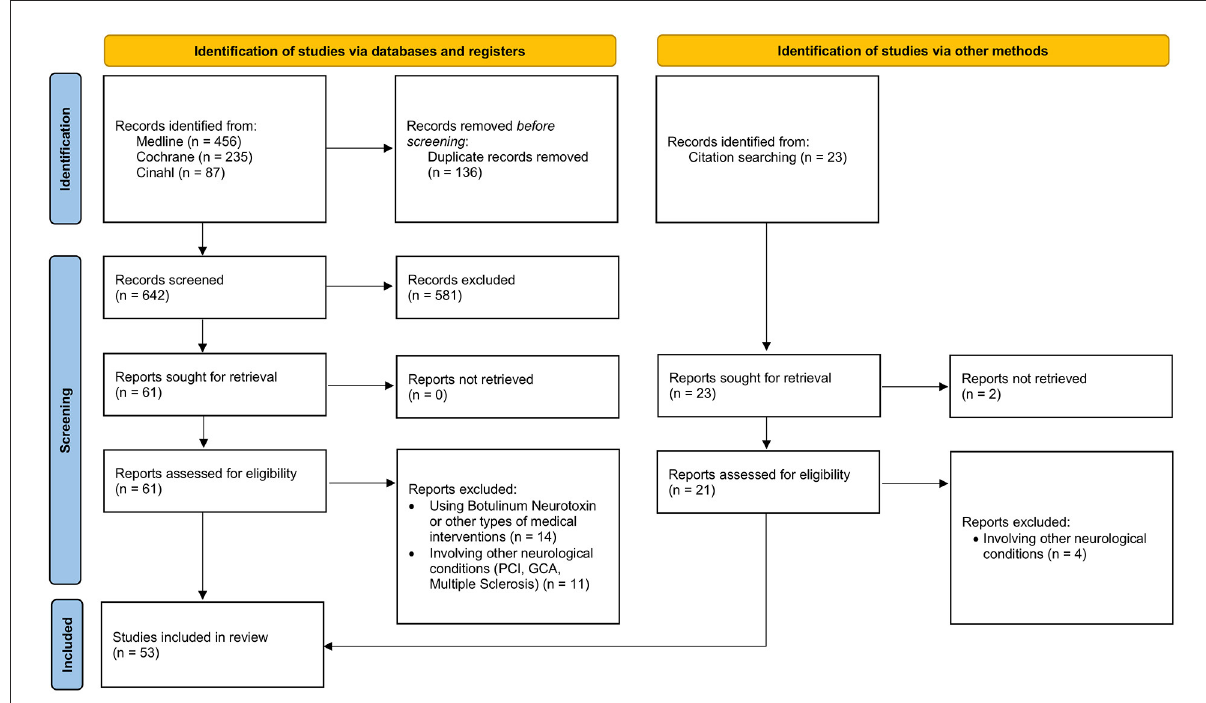
FIGURE1 Flow chart of the literature search on physical therapy interventions for the correction of equinus foot deformity in post-stroke patients with triceps